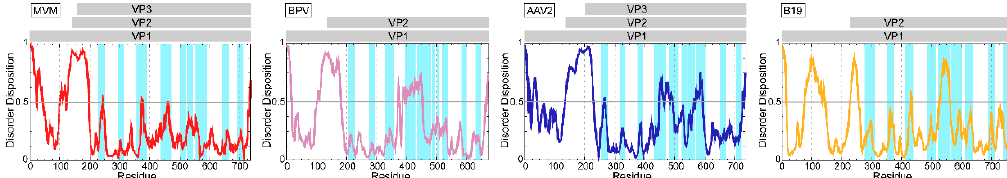
Figure 5. Disorder prediction for type members MVMp (red), BPV (pink), AAV2 (blue), and Parvovirus B19 (orange) VP1 by the PONDR_fit application [72]. Regions above 0.5 on the Y-axis are predicted to be disordered. Gray line drawings above the images indicate the approximate positions of the VPs. The regions highlighted in light blue indicate the locations of the surface exposed loops, the tops of which are defined as variable regions.